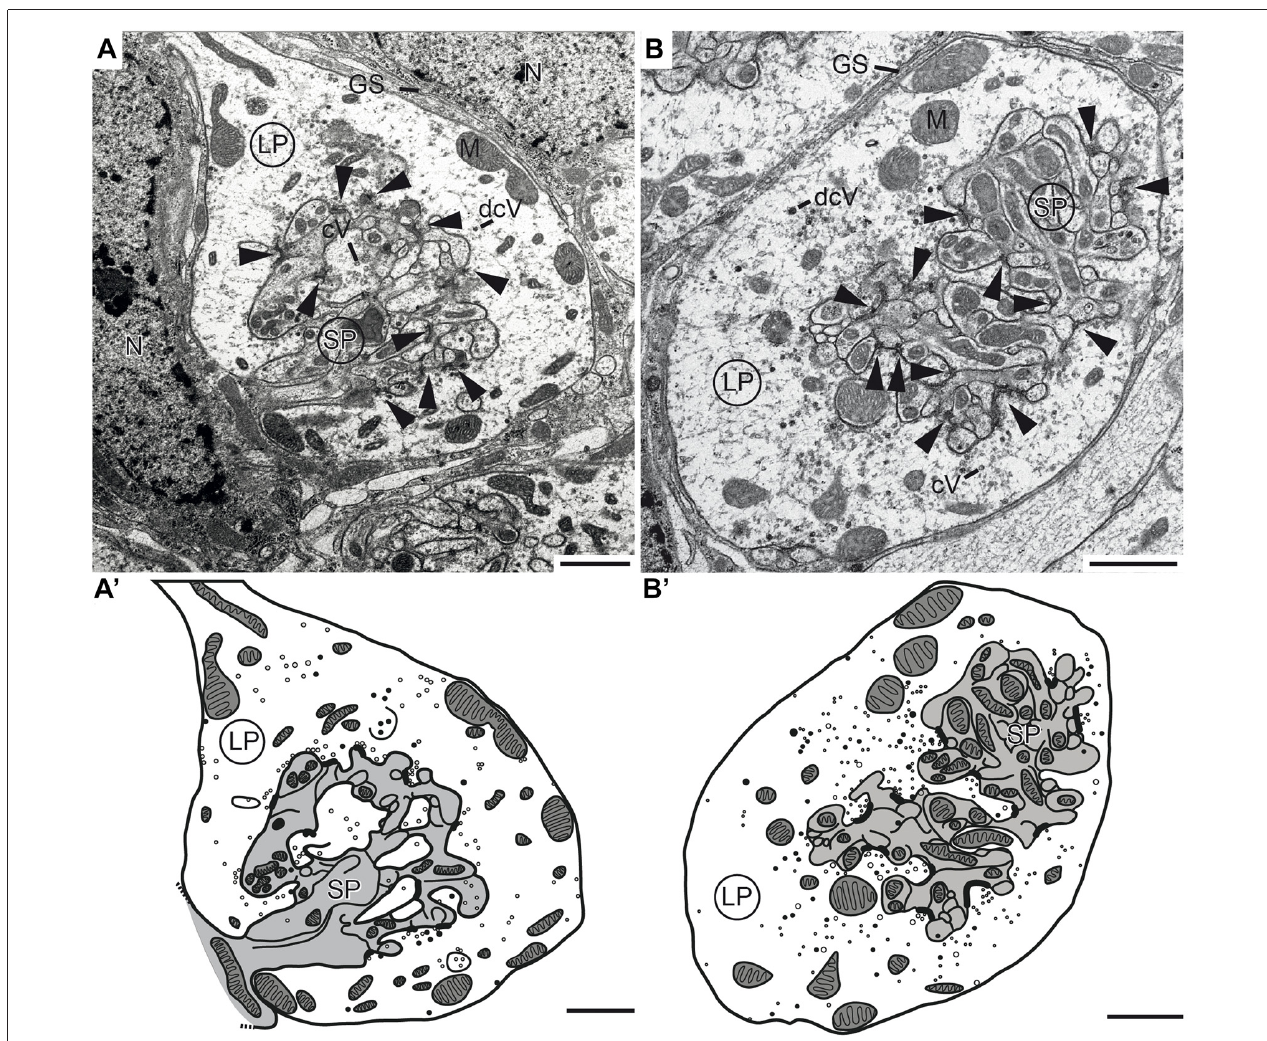
FIGURE 6 | Transmission electron micrographs showing the ultrastructure of microglomerular synaptic complexes in the LBU (A,A’) and the MBU (B,B’) of the lateral complex (LX). (A) The complex consists of one large profile (LP) enclosing many small profiles (SPs). The LP contains clear vesicles (cVs), some large dense core vesicles (dcVs) and many mitochondria (M) and forms numerous synaptic connections with the SP (arrowheads). A glial sheath (GS) is wrapped around the complex. It is located in proximity to two nuclei of other cells (N). (A’) Drawing of the complex in (A) shows the borders of the profiles, organelles and synaptic connections. All parts of the LP are shown in white and the SP in gray. (B,B’) The structure of the complex in the LBU is similar to the one in the MBU: one LP encloses many SP. Scale bars = 1 µ